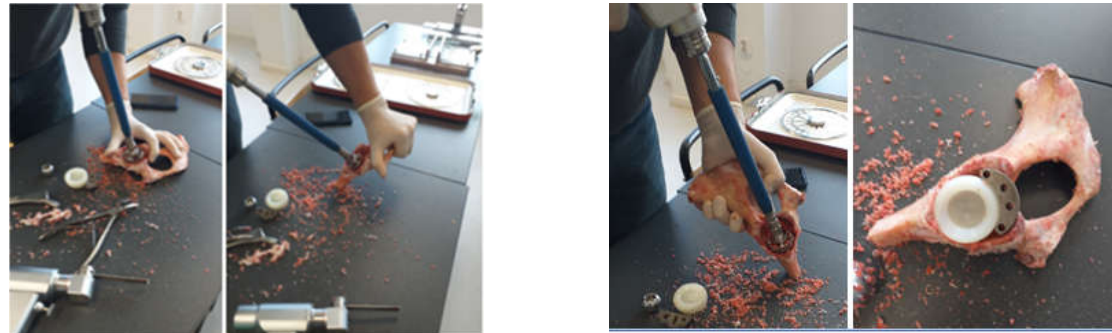
Figure 3. Adaptation of the acetabular cavity to the polyethylene cup (milling, cutting, and removal stages).